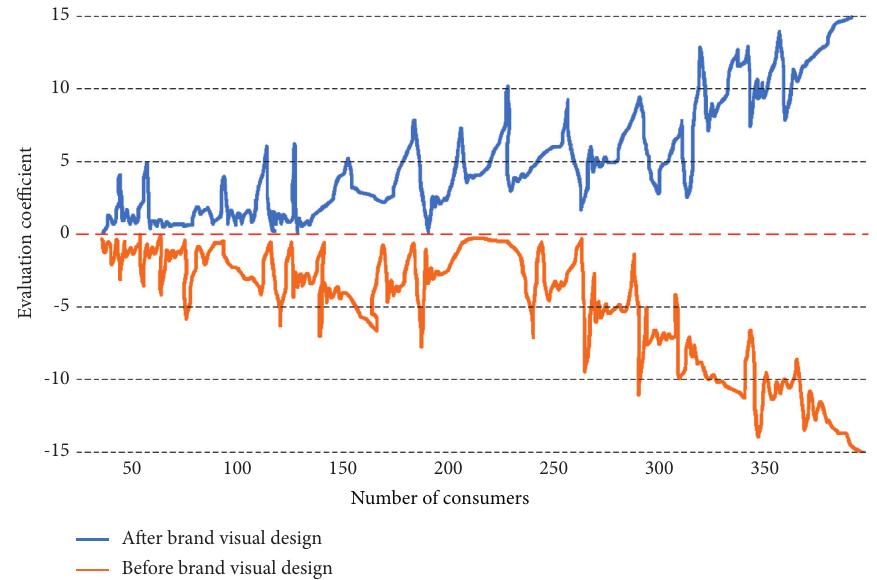
Figure 4: Consumer evaluation coefficient before and after brand visual